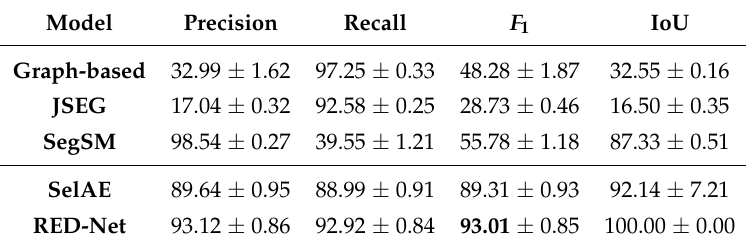
Table 3. Evaluation results including the standard deviation for the two architectures using the chosen parameters after